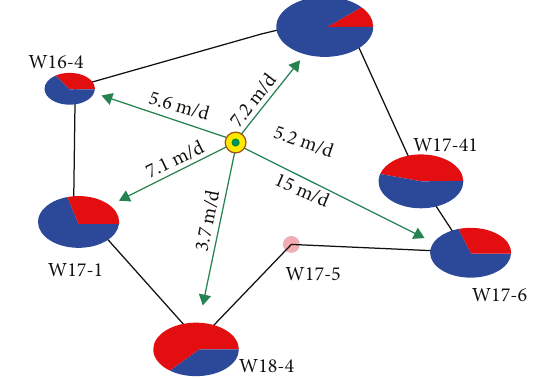
Figure 15: MRF pilot well pattern and bacteria fl ow velocity [31,